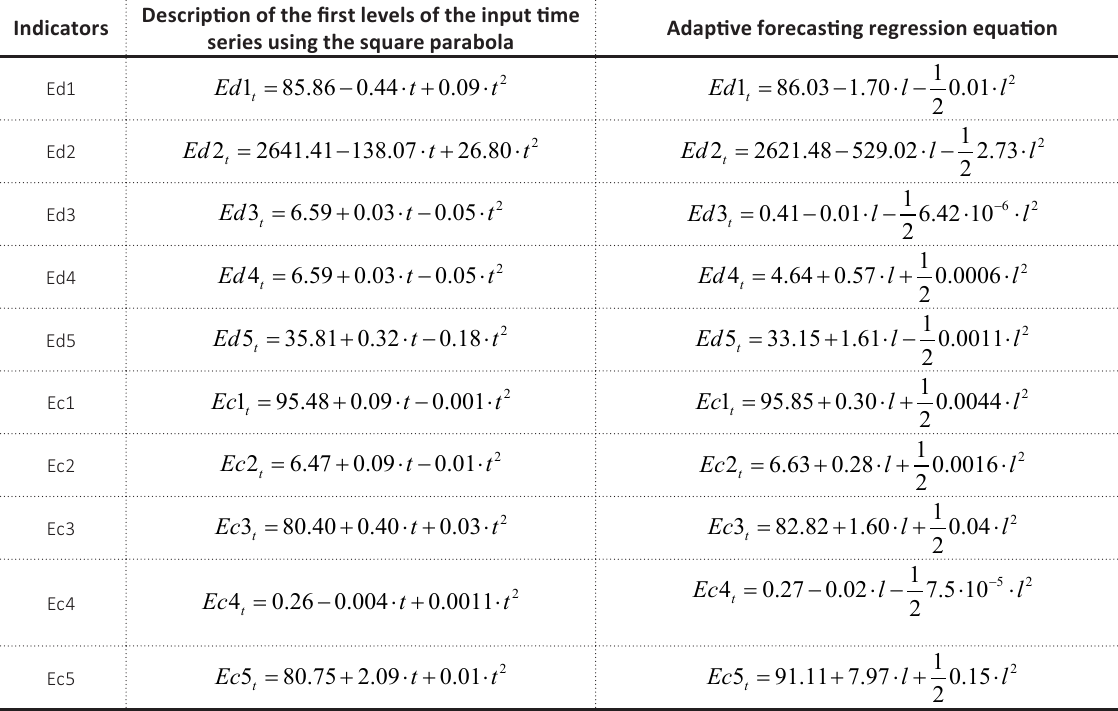
Table 2. Interim calculations of the trend equation of adaptive forecasting in the context of science and education, as well as environment and human health, for 1999–2018 Indicators Description of the first levels of the input time Adaptive forecasting regression series using the square parabola